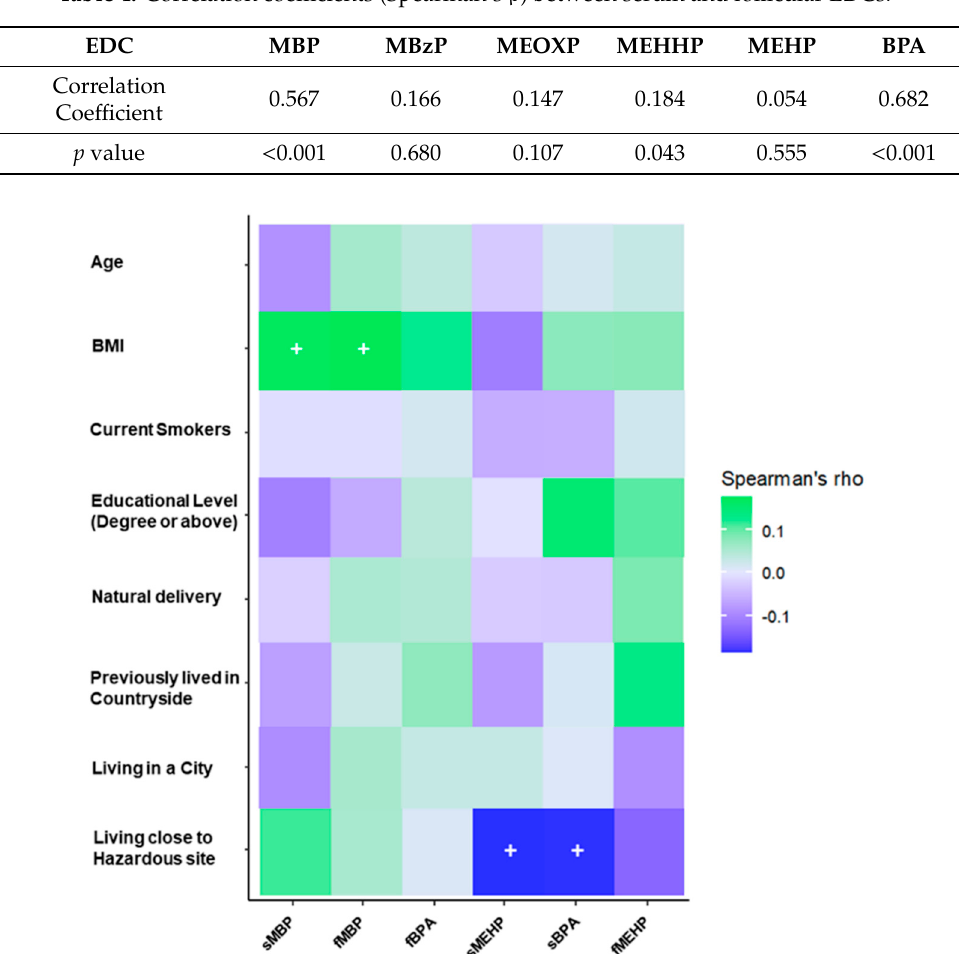
Figure 4. Spearman’s correlations between relevant demographic information and serum and follicular fluid BPA, MEHP and MBP. ( + : p ≤ 0.05). sBPA: serum BPA; fBPA: follicular fluid; sMEHP: